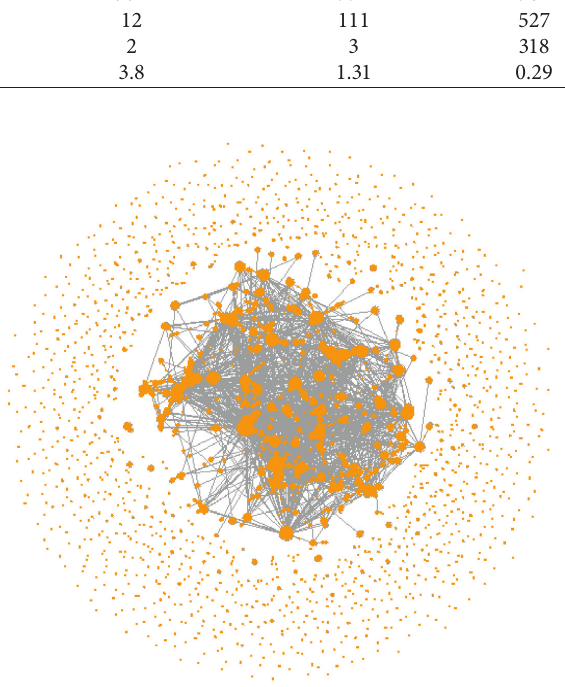
Figure 1: Patent cooperation network in BTH Urban Agglomeration.